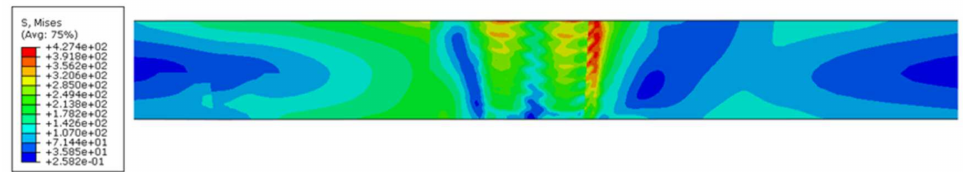
Figure 10. FE prediction of von Mises stress (MPa) distribution in the DMW joint after machining.